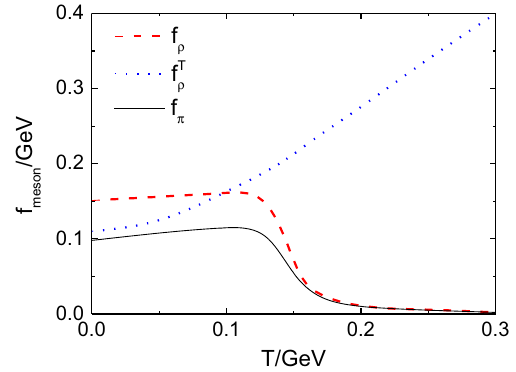
Fig. 3 Decay constants of pion, f π ( solid curve ) in Eq.(13) and ρ meson, f ρ ( dashed curve ) and f T ρ ( dotted curve ) in Eq.(19) at finite temperature